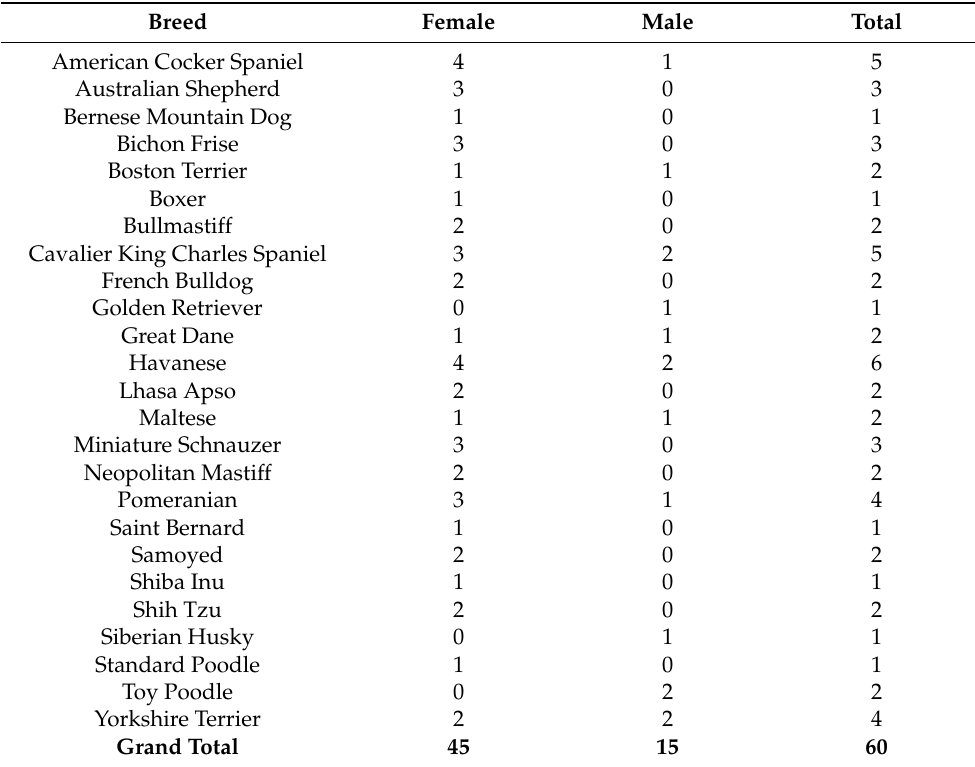
Table 1. Study population demographics: a list of breeds, number of dogs and sex per breed is